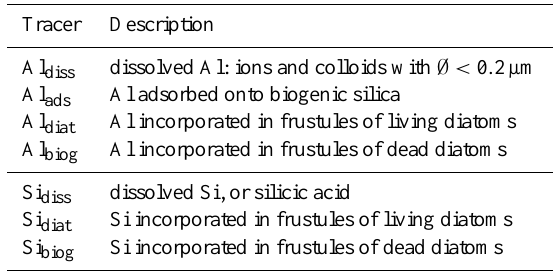
Table 1. Aluminium and silicon tracers in the model.